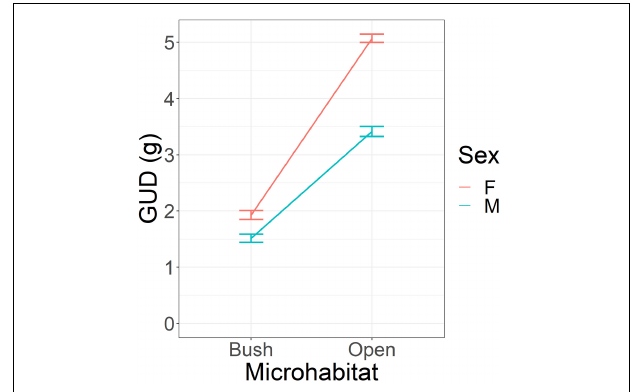
FIGURE 2 | Giving-up densities (GUD) of mice in the vivarium according to microhabitat (bush and open) and sex. Females (F) have lower GUDs than males (M). All mice had lower GUDs in the bush than the open. Error bars represent standard errors of the means.